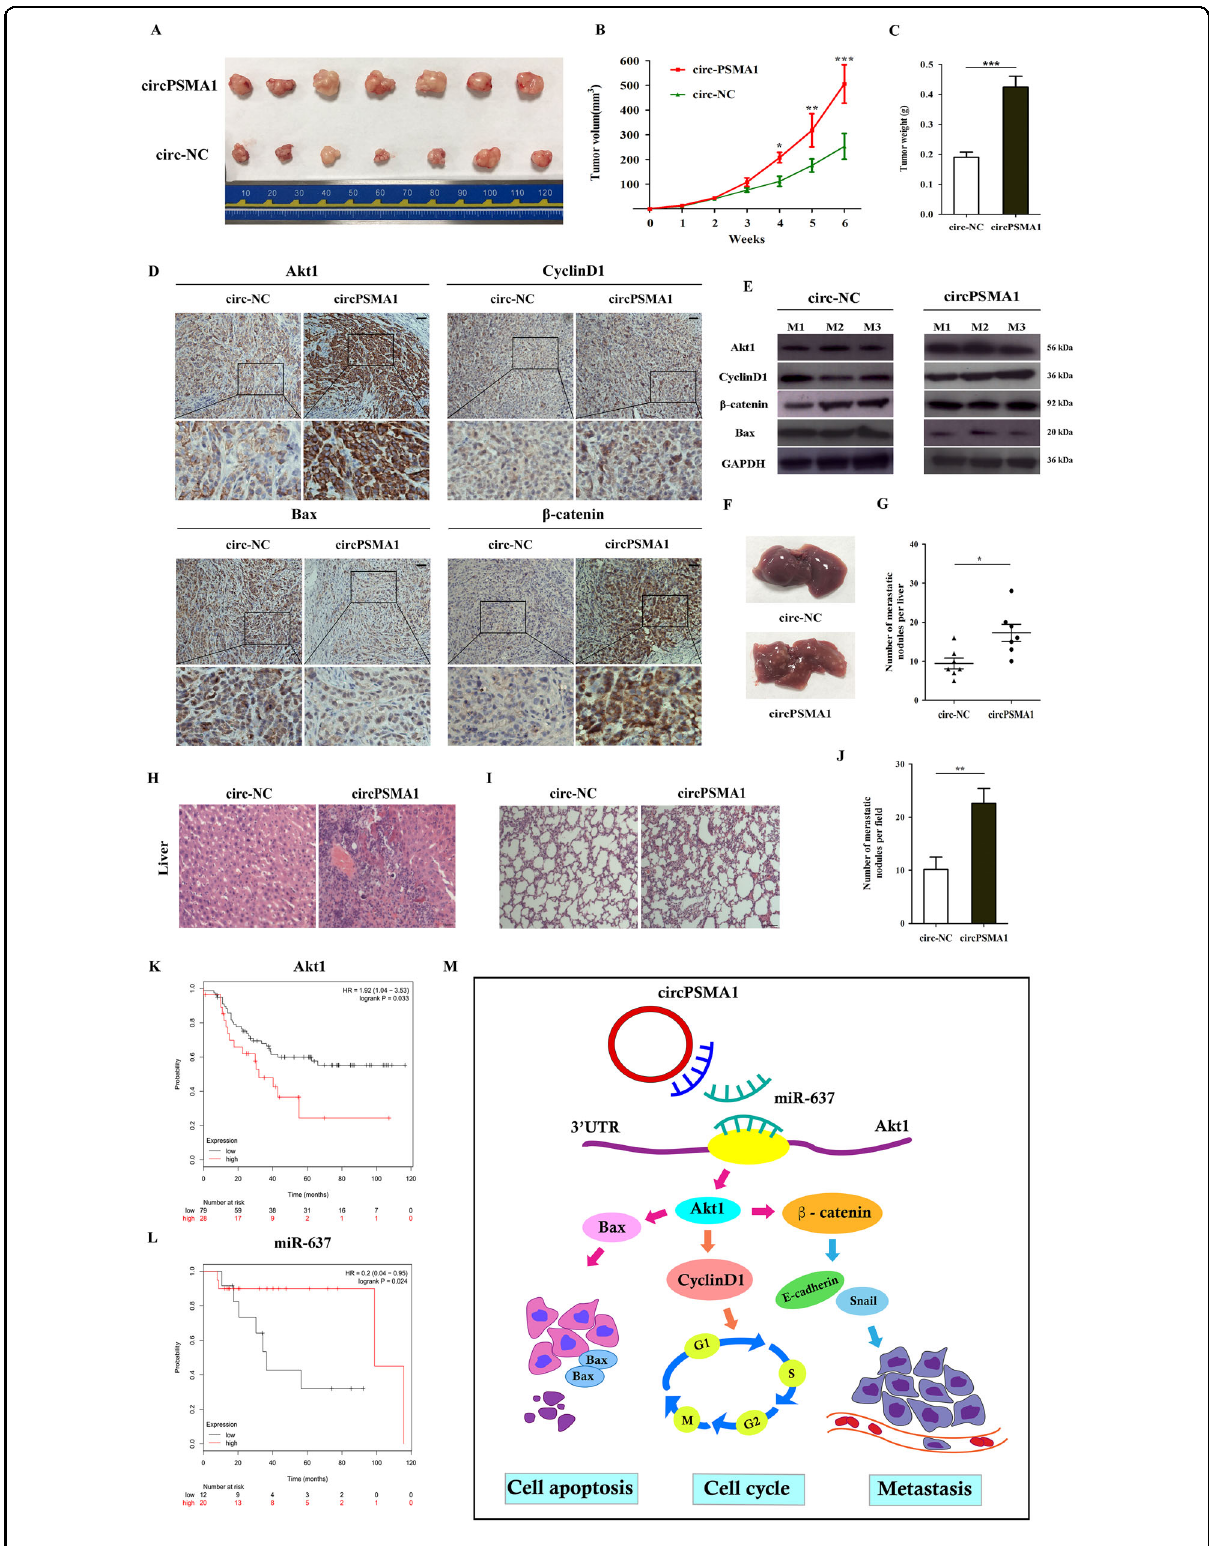
Fig. 8 (See legend on next